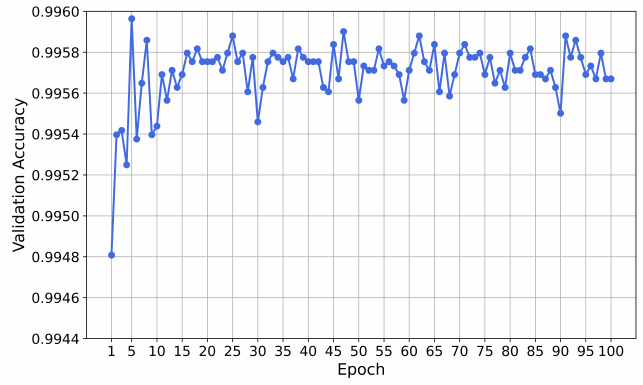
Figure 16. Validation accuracy of the neural network for each